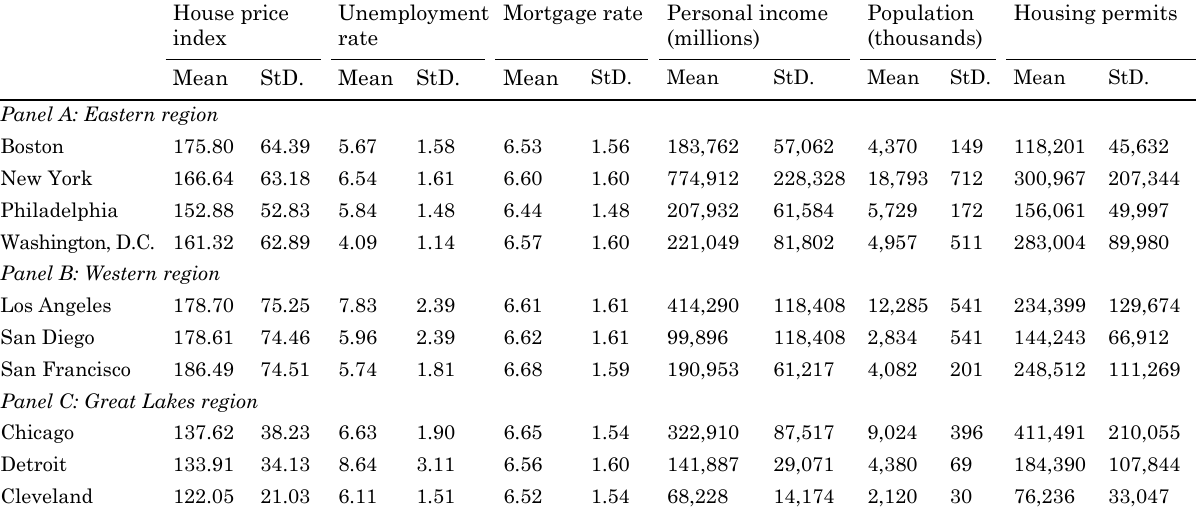
Table 1. Summary statistics of each